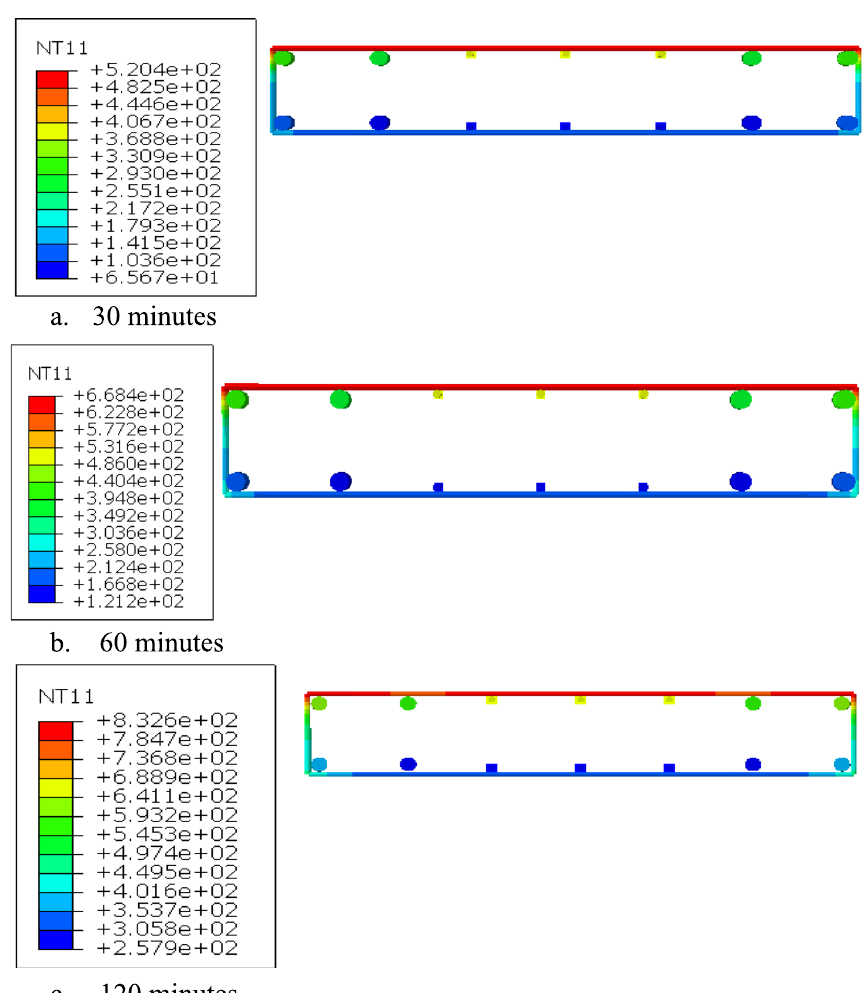
Fig. 38 Temperature distributions on the surface of reinforcements for different fire durations. a 30 min. b 60 min. c 120